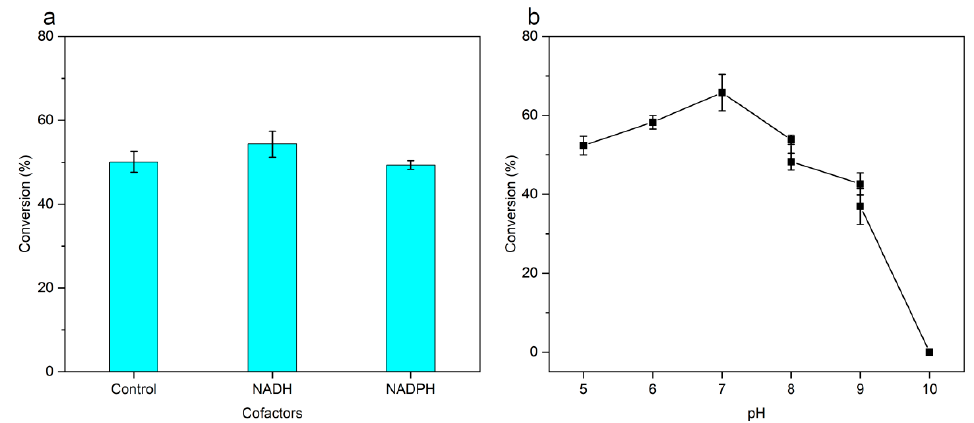
Figure 5. The cofactor preference of TQ-2 whole-cell biocatalyst ( a ) and the effect of pH on the reduction of acetophenone ( b ). The general reaction conditions used otherwise stated: 2 mM of substrate, 0.1 g/mL of microbial cells, 5 mL of phosphate buffer (100 mM, pH 7.4), and 600 rpm; ( a ) NADH and NADPH were added with the final concentration of 5 mM; ( b ) buffer used: pH 5.0–8.0 phosphate buffer, pH 8.0–9.0 Tris-HCl buffer, pH 9.0–10.0 Gly-NaOH buffer.